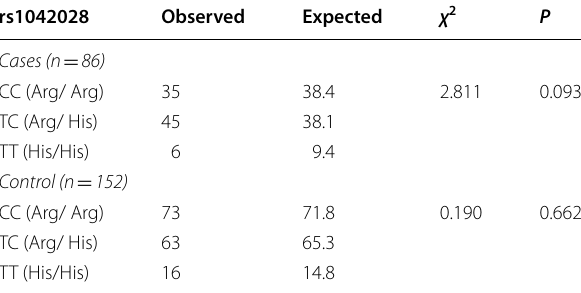
Table 3 Results of Hardy–Weinberg equilibrium analysis of rs1042028 genotypes among cases and control